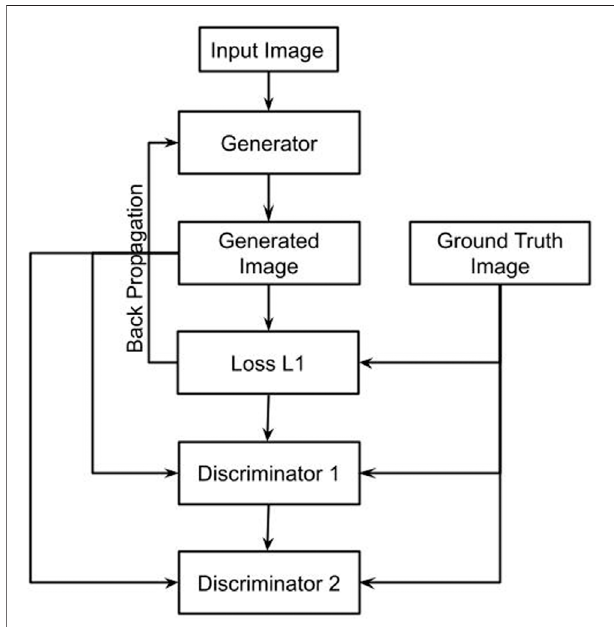
FIGURE 3 | Flowchart of the proposed